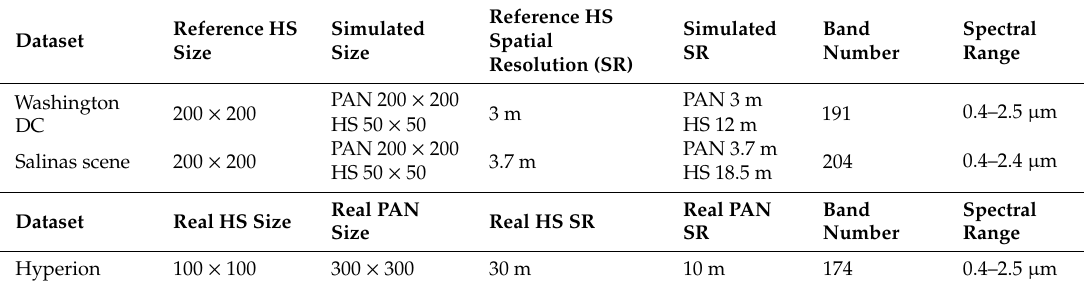
Table 1. Characteristic of the